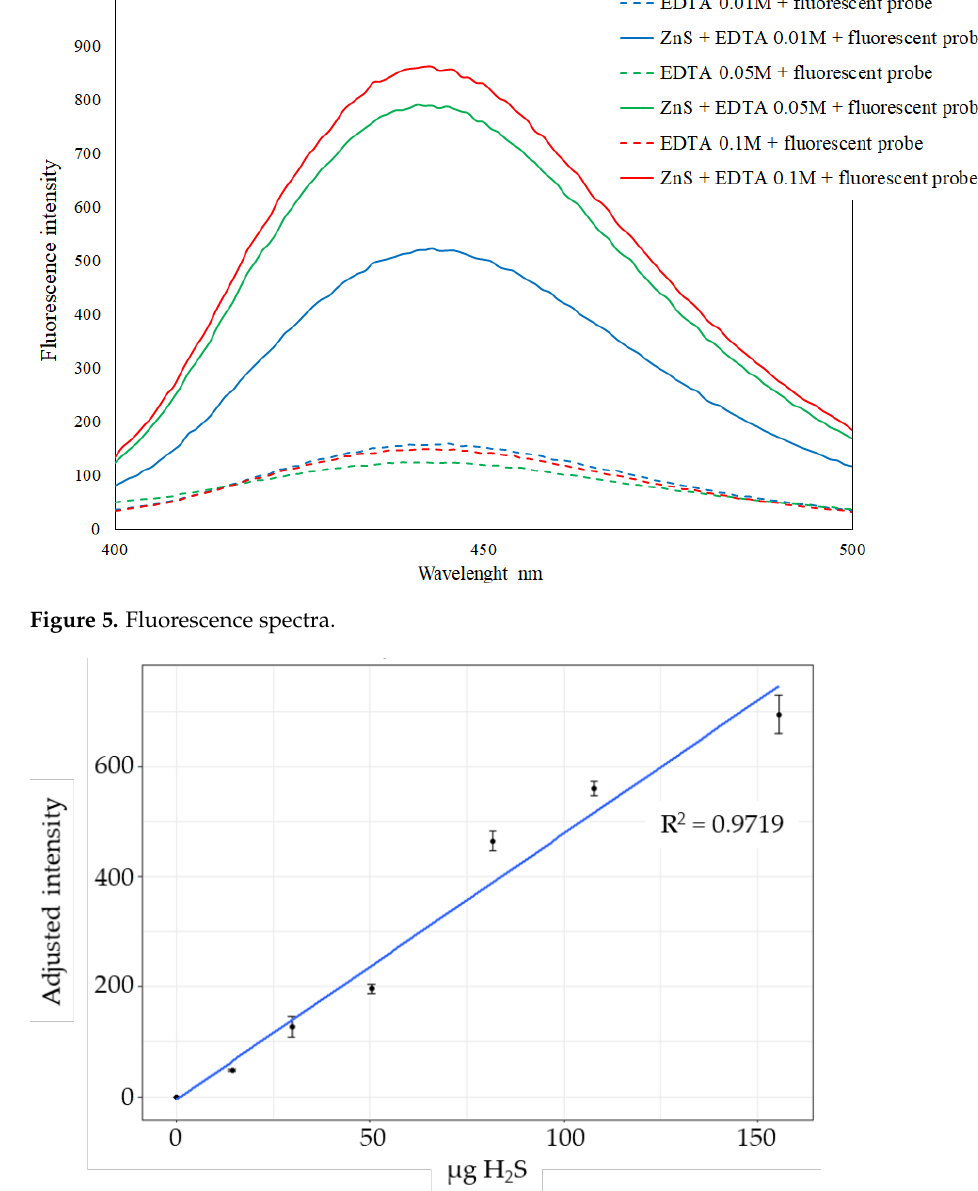
Figure 6. Calibration curve.